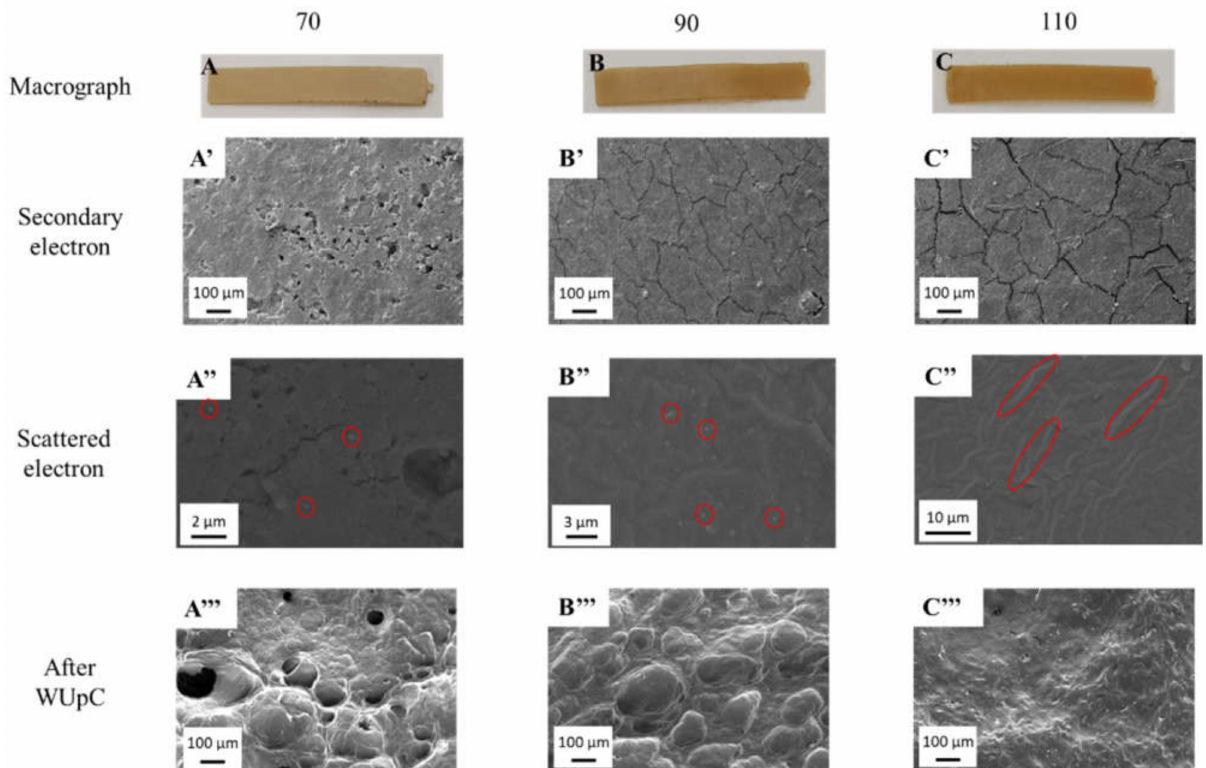
Figure 3. Macrographs ( A – C ) and micrographs of bioplastics with different ZnO nanoparticle concentrations (0 wt%, 1.0 wt%, 2.0 wt% and 4.5 wt%) processed at different mould temperatures (70 ◦ C, 90 ◦ C and 110 ◦ C), using a secondary electron detector and a scattered electron detector before (( A’ – C’ ) and ( A” – C” ), respectively) and after water uptake capacity (WUpC) tests ( A”’ – C”’